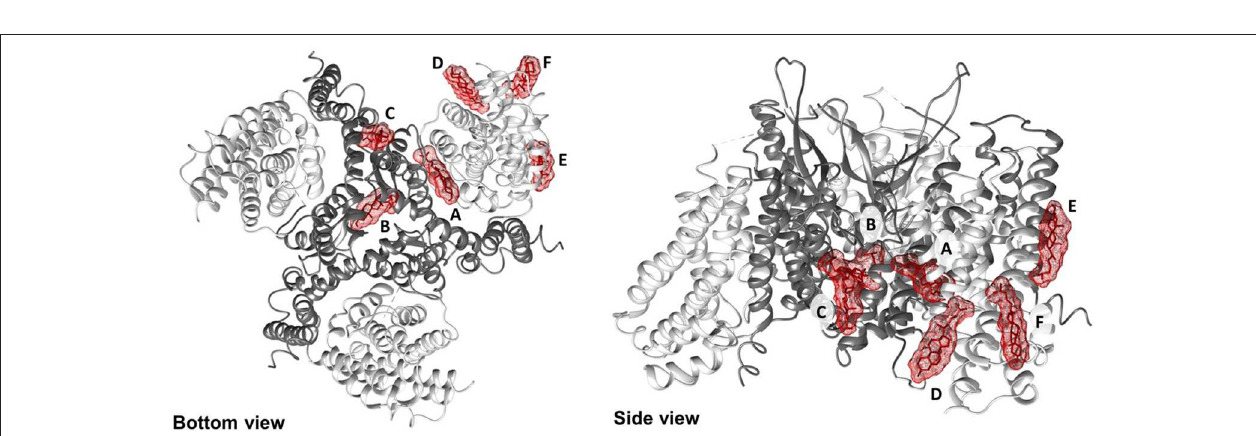
FIGURE 4 | 2D schematic representation of a protomer organization. TransMembrane domains (TMs) of hASCT2 are depicted in dark gray (scaffold domain) or light gray (transport domain); HP1 and HP2 hairpins connect TM6-8; loops between TMs are indicated in lines. N- and C-termini of the protein face to the intracellular space delimited by the membrane.